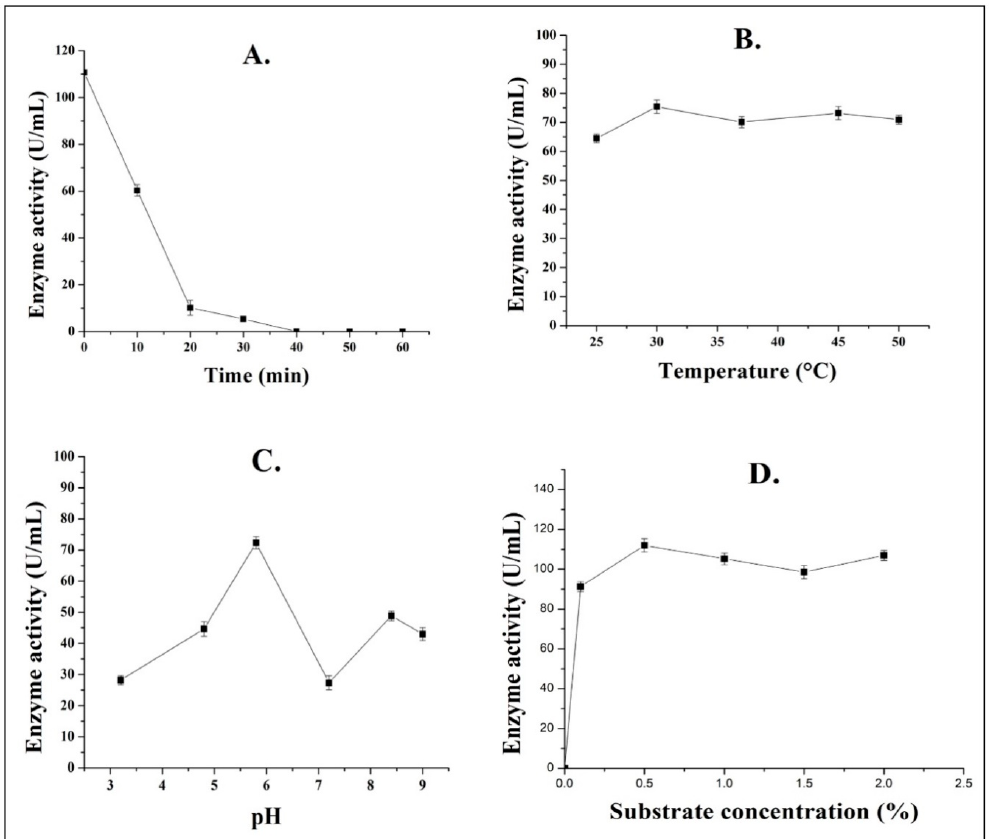
Figure 3. Effect of various factors on enzyme activity of partially purified pectinase enzyme from strain Aspergillus spp. Gm. ( A ), thermal stability at 60 ◦ C; ( B ), temperature; ( C ), pH; and ( D ), substrate con- centration.